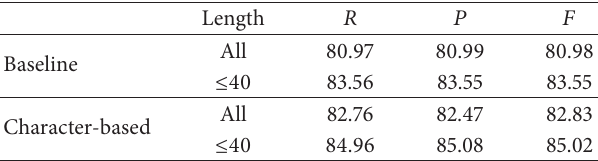
Table 1: The effect of the character-based model on TCT. Length 𝑅 𝑃 𝐹 All 80.97 Baseline